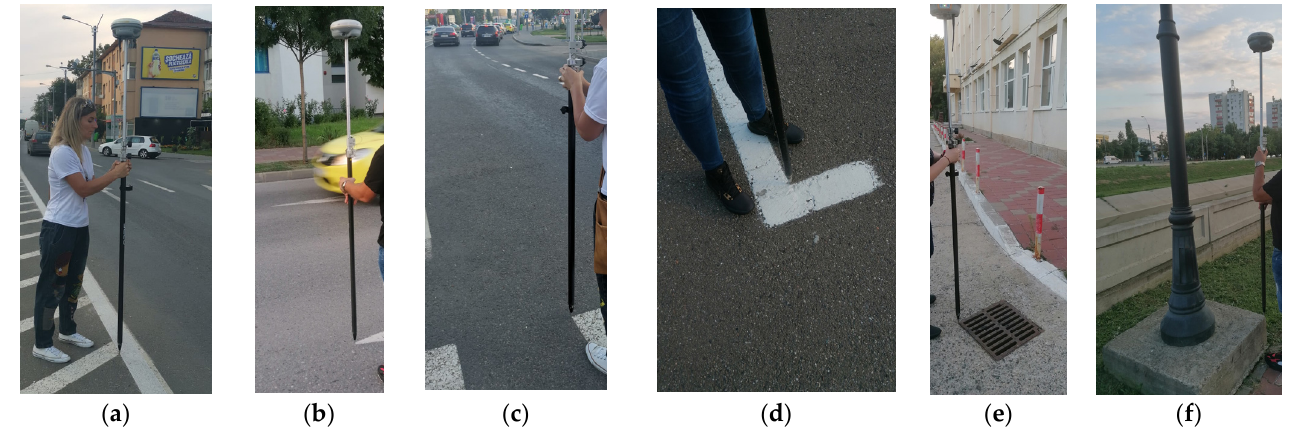
Figure 3 . Ground control points (GCPs) and check points (ChPs) location: ( a ), ( b ) street marking, ( c ) crosswalk, ( d ) parking marking, ( e ) sewer corner, ( f ) corner of lighting pole.